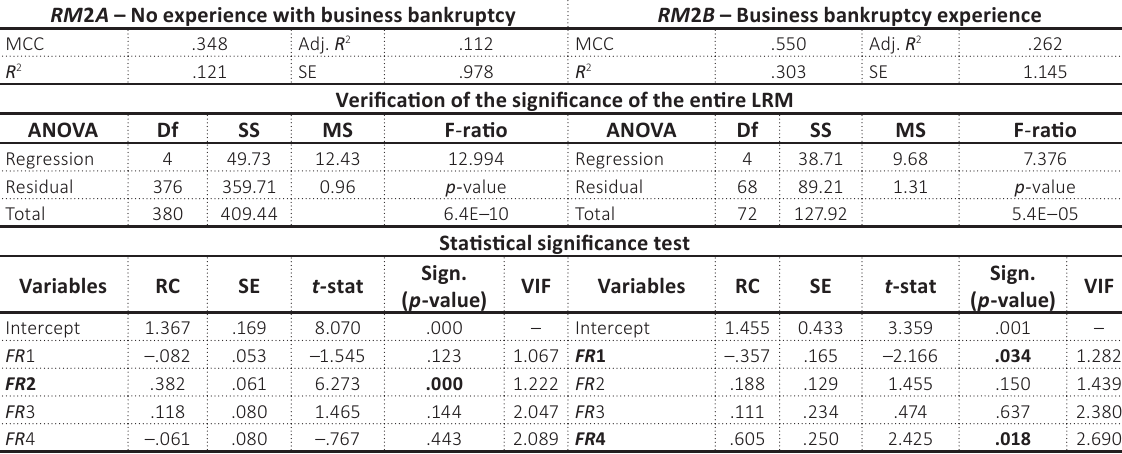
Table 4. The impact of financial risk indicators on the perception of the future of business according to the